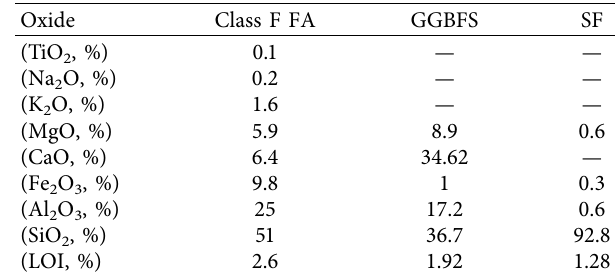
Table 1: Chemical composition of